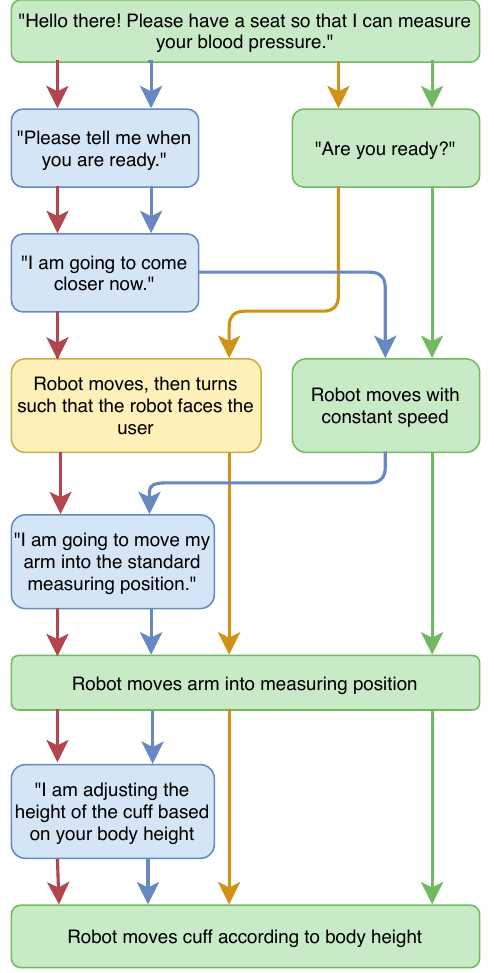
Figure 6: Flow of the experiment, from the start until the measure- ment. The colour of arrows correspond to the different conditions (green = condition 1, blue = condition 2, orange = condition 3, red = condition 4). The colour of the boxes indicate if the robot behaviour is regular (green) tailored for adaptation (yellow) or transparency